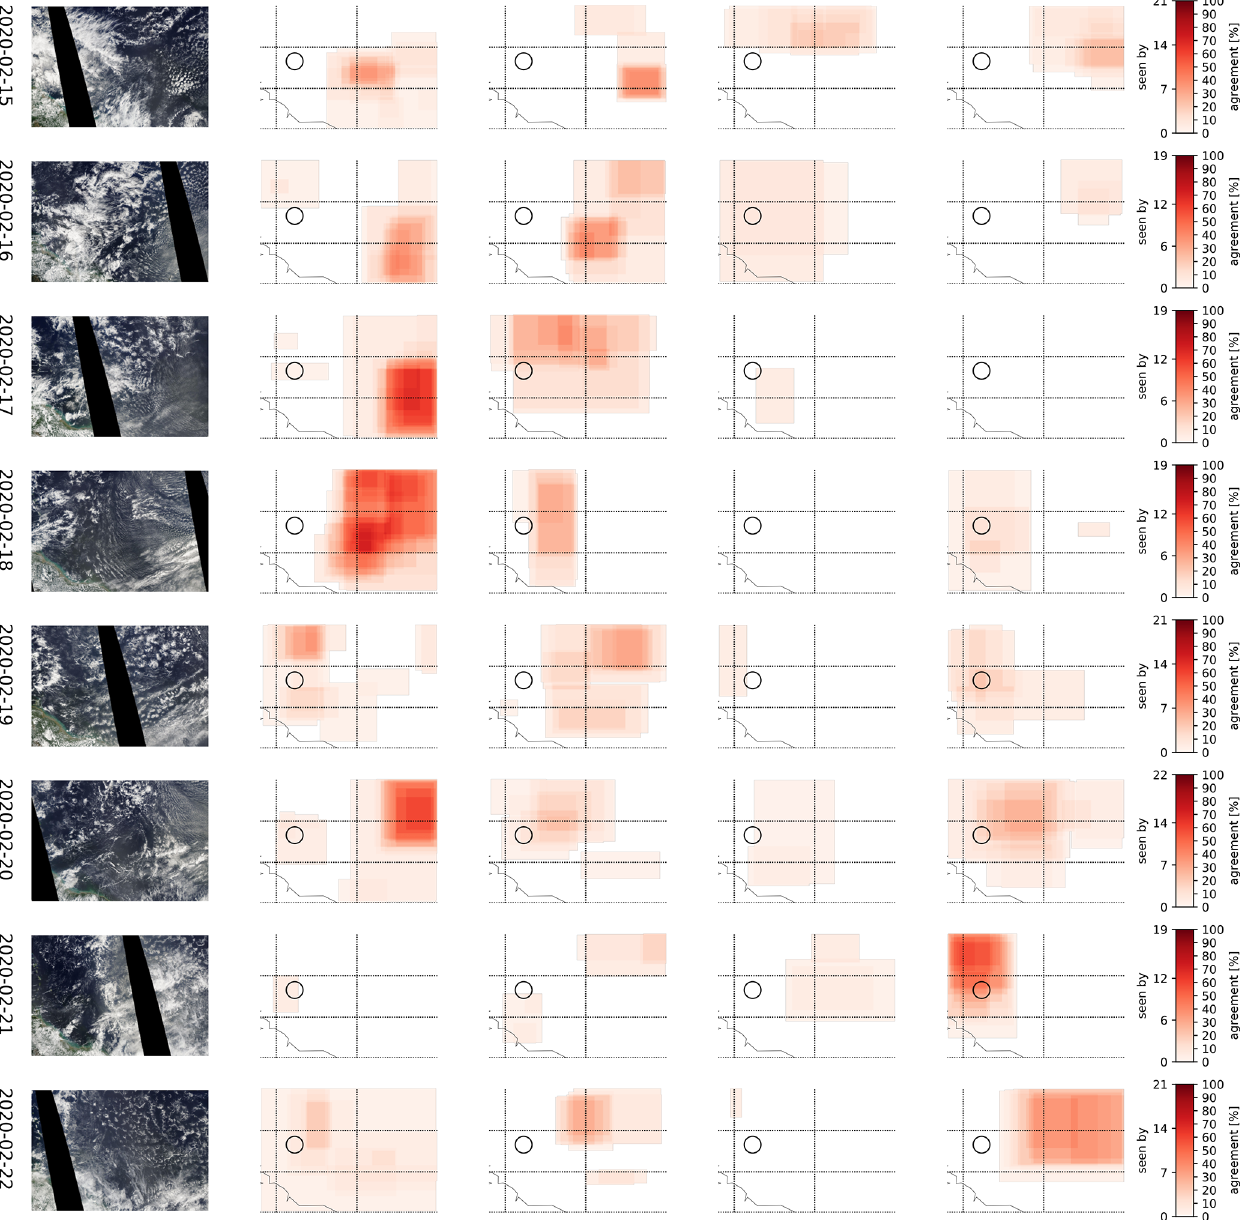
Figure A1. Heatmaps of manual classifications based on MODIS (Aqua and Terra) visible imagery. Left to right: visible imagery during an Aqua overpass and user agreement on sugar, flowers, fish and gravel. The circle marks one focus area of the EUREC 4 A field campaign and the main flight pattern of the participating research aircraft HALO (Konow et al., 2021). Coastlines are based on GSHHG shapefiles (Wessel and Smith, 1996). Please note that the date format in this figure is